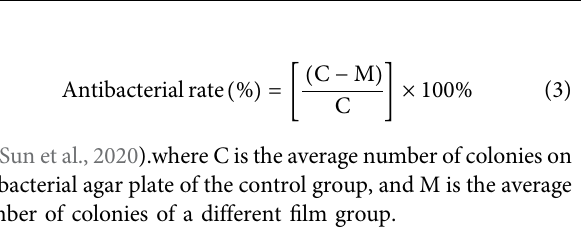
Frontiers in Bioengineering and Biotechnology |